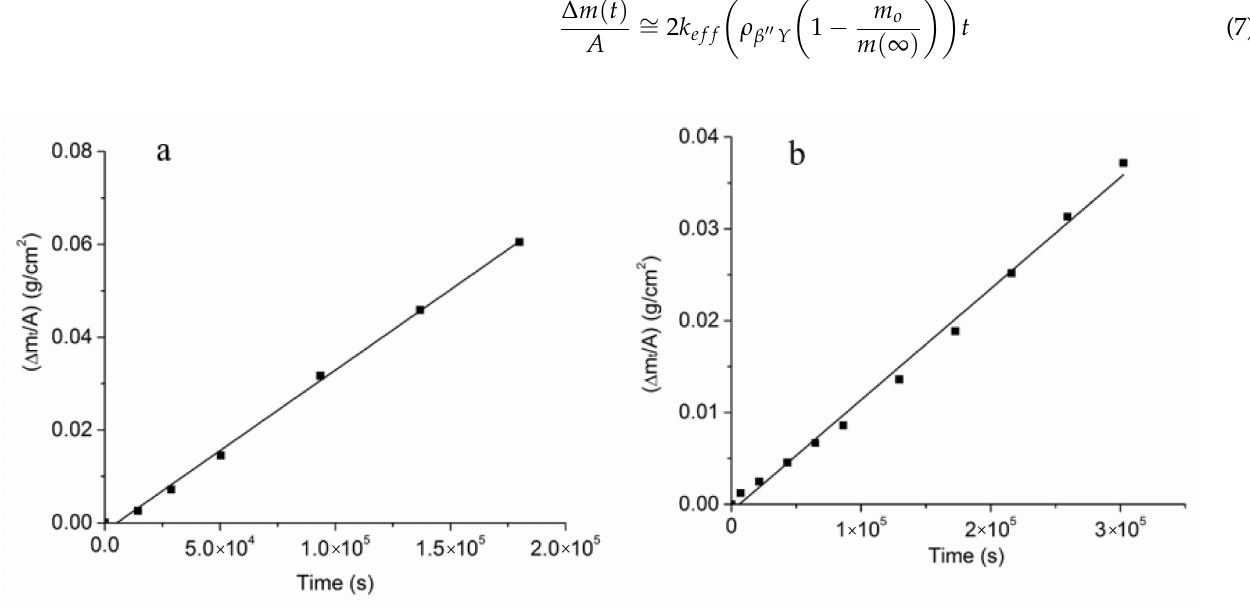
∆ m ( t ) Figure 8. ( a ) A plot of vs. t for a sample with a 2.5 µ m Na- β ”-alumina surface coating. From A ∆ m ( t ) the slope, the k ef f is obtained. ( b ) A plot of vs. t for a sample with a 15 µ m Na- β ”-alumina A surface coating. From the slope, the k ef f is